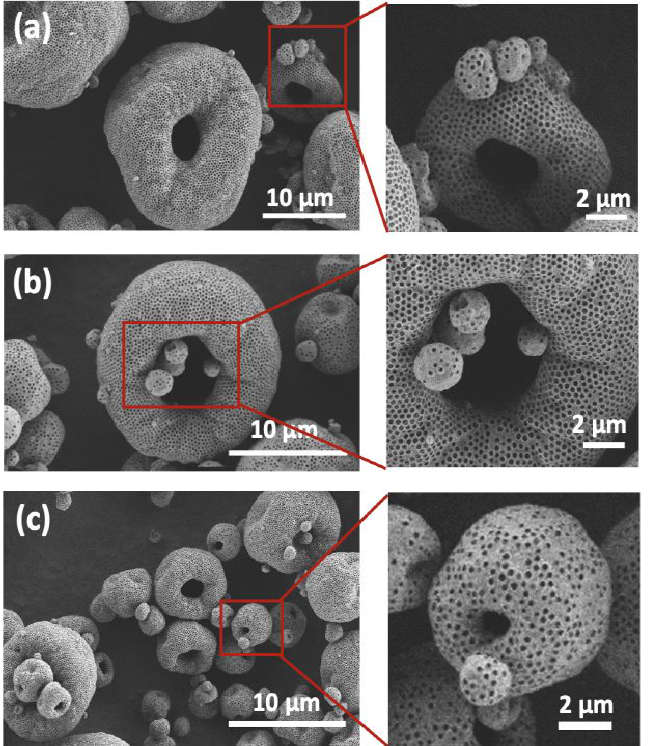
Figure A2. SEM images of SD microparticles synthesized using 0.4Pt@PS with PS sizes of 385.6 nm at different SD slurry concentrations. ( a ) 10 wt.%; ( b ) 15 wt.%; ( c ) 20 wt.%. Microparticles with ≤ 2 µm diameter have spherical shape as demonstrated on zoomed in images on the right.